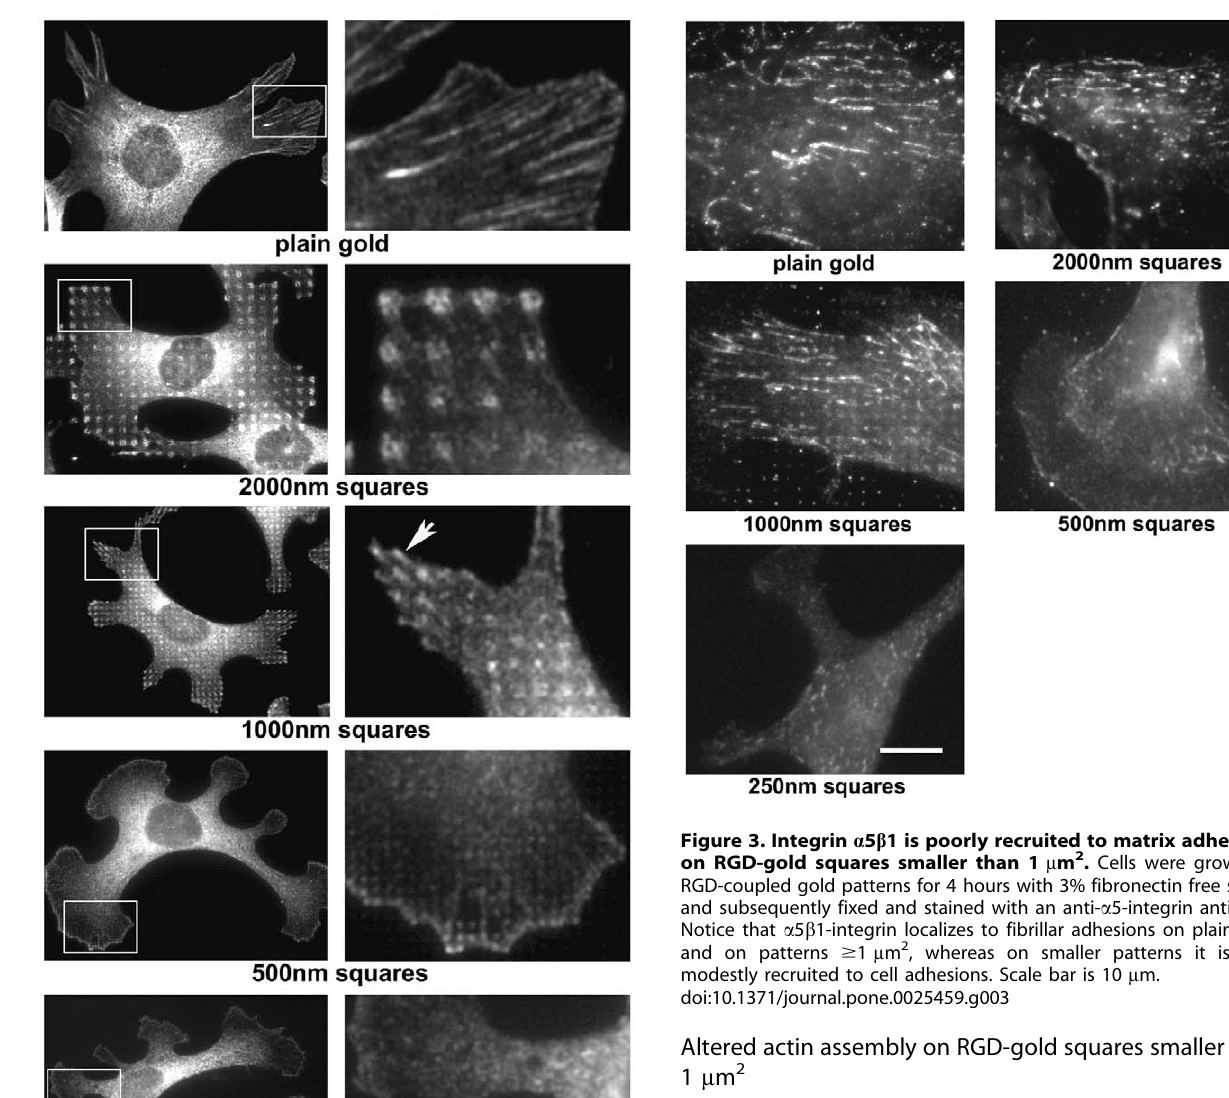
formed all around the perinuclear cell body. On the 500 nm and the 250 nm patterns, cells were also less elongated with an average long axis of 55 m m. In comparison, the long axis for cells on the larger RGD-gold patterns was measured to be 75–80 m m in average, and it reached about 100 m m on plain gold (Fig. 4).